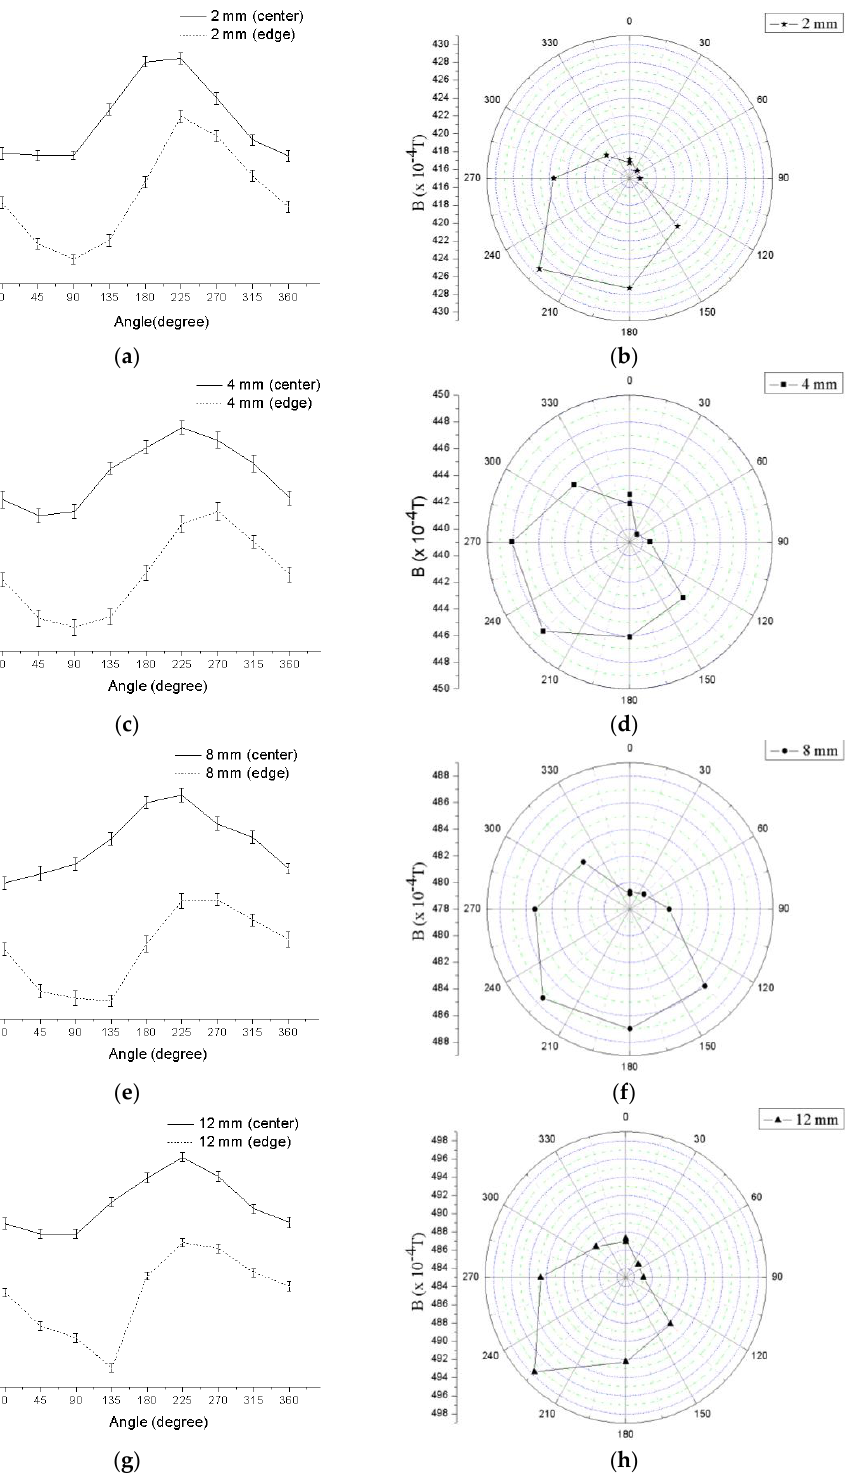
Figure 4. Induced magnetic field versus the rotation angle: 2 mm thick sample, at the center and edge ( a ) and angular dependence at 2 mm from the center ( b ); ( c – h ) the equivalent but for samples with thicknesses of 4, 8, and 12 mm, respectively.